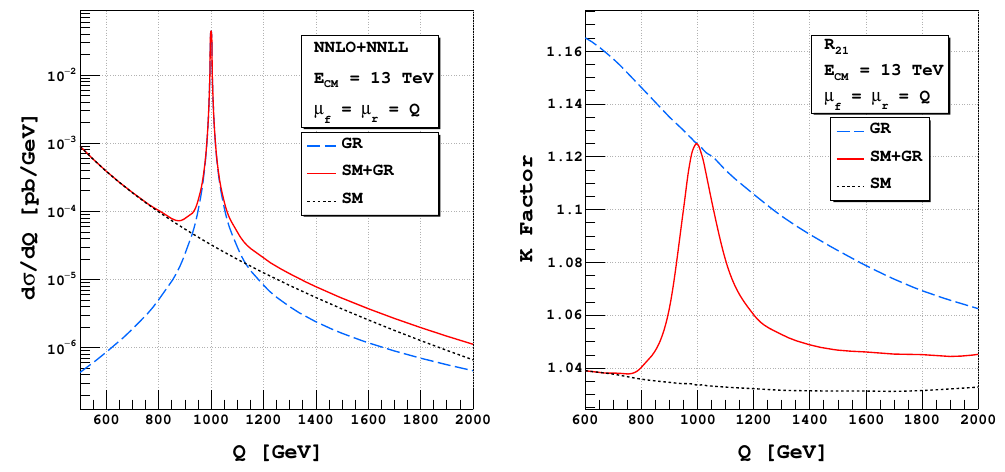
Figure 7 . Invariant mass distribution of dilepton for the SM, GR model and for the signal (left) and their corresponding K-factors with respect to NLO